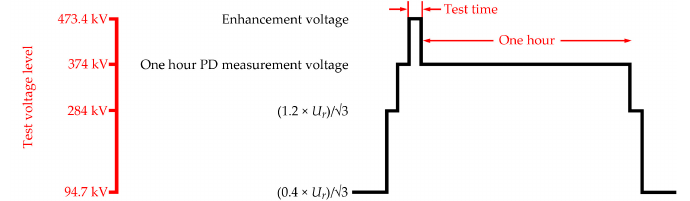
Figure 27. Time sequence for the application of test voltage for induced voltage test with partial discharge measurement (IVPD).